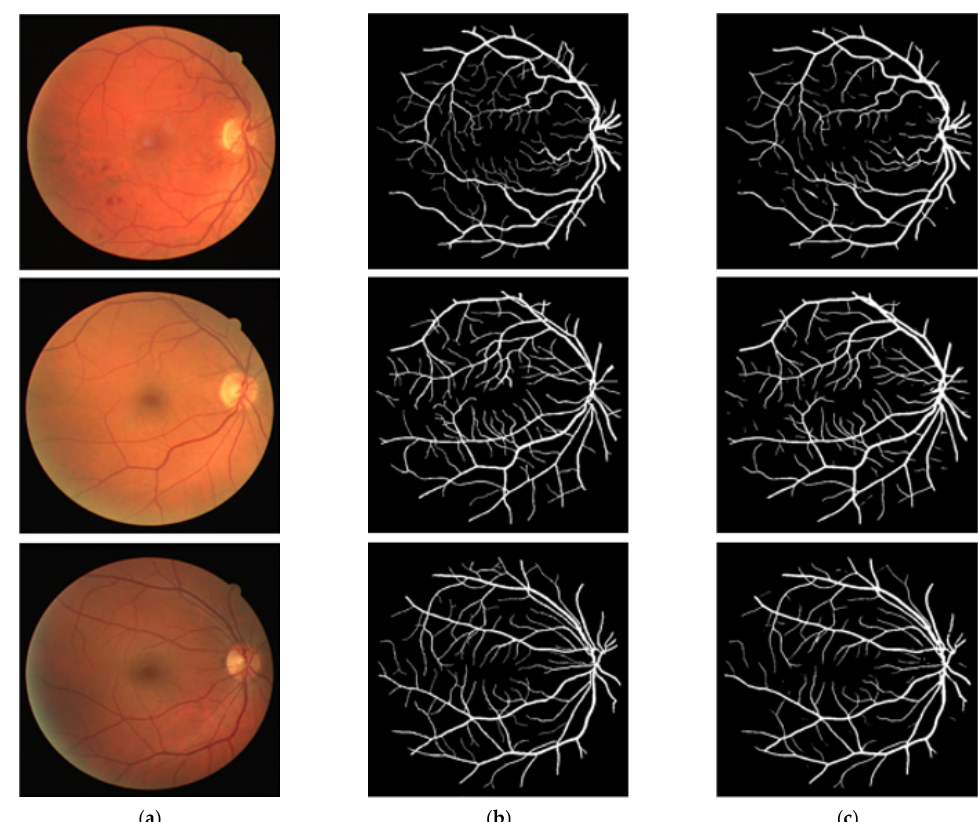
Figure 9. Visual results of the proposed DSA-Net Using the DRIVE Dataset: ( a ) Original input image, ( b ) Expert annotation, and ( c ) Predicted image mask by DSA-Net.